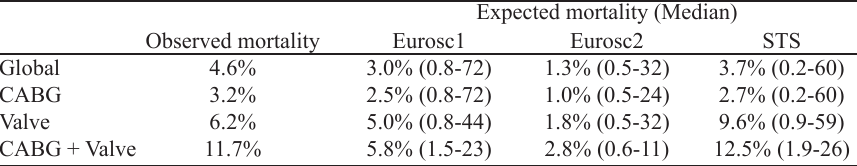
Table 2. Expected and observed